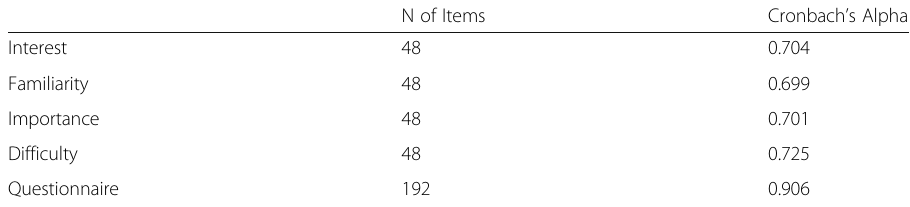
Table 4 Cronbach ’ s Alpha Test for the Textbook Assigned Topics Questionnaire